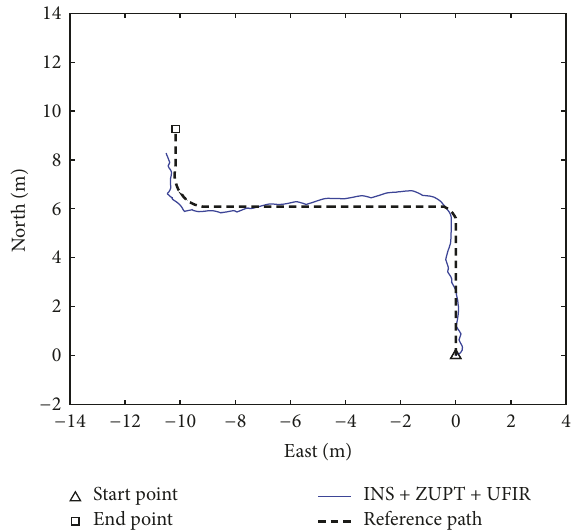
Figure 6: Trajectory measured by INS + ZUPT + UFIR for the second group of possible parameters (Group